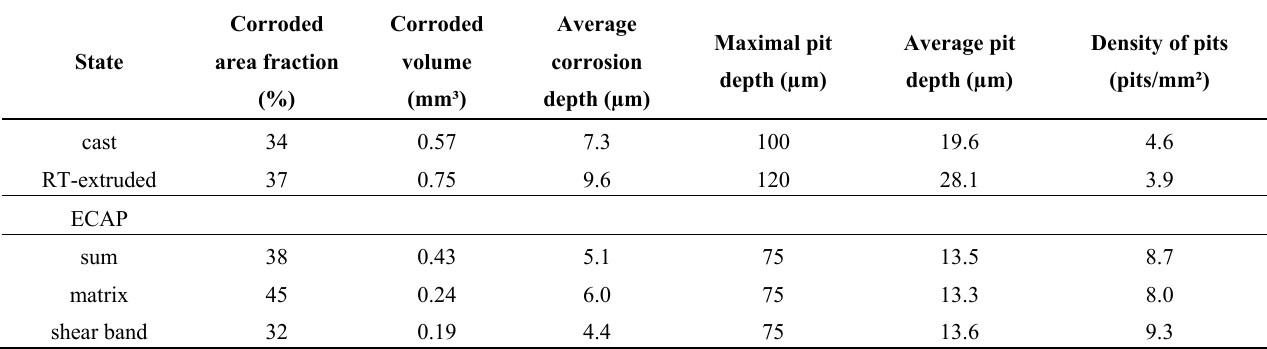
Figure 9. Depth mapping of pitting corrosion after macro-scale potentiodynamic polarization of the ECAP material (depth scale color-coded); the left inset shows the details; the right inset shows the corresponding EBSD pattern quality map indicating deformation localization (position of the insets is marked by the box in the overview map). Table 3. Characteristics of the corrosion appearance for the studied conditions after macro-scale potentiodynamic polarization (Ø 10